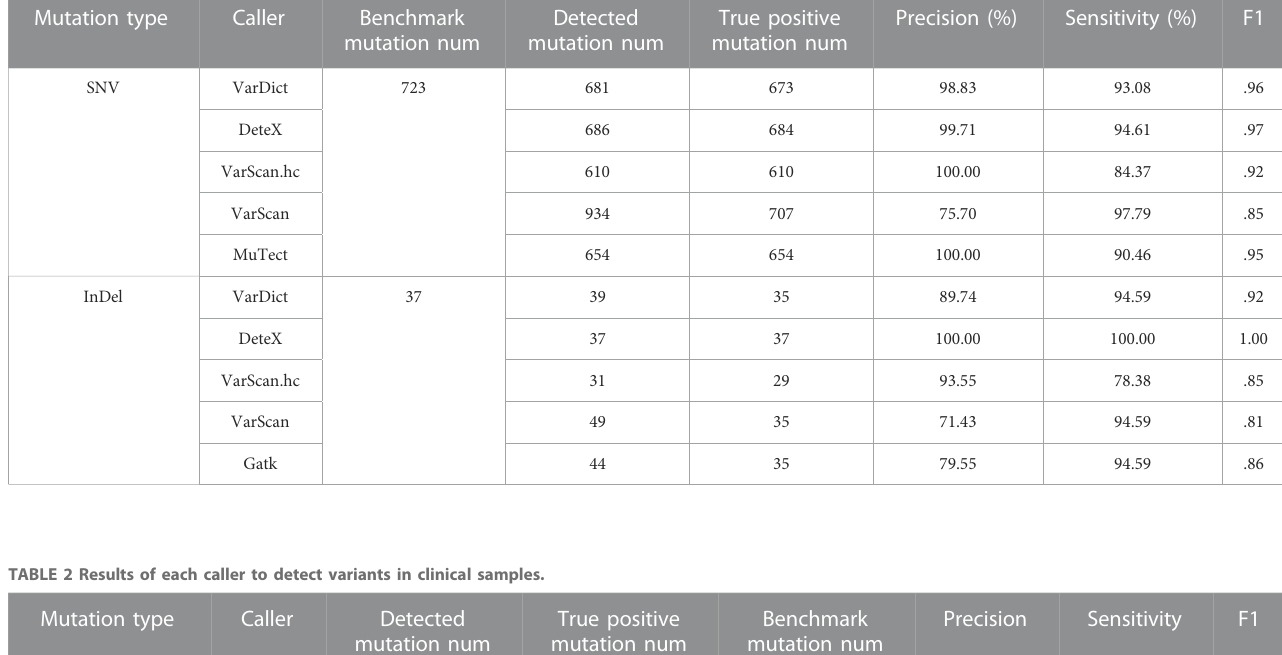
TABLE 1 Results of each caller to detect variants in TCGA samples. Mutation type